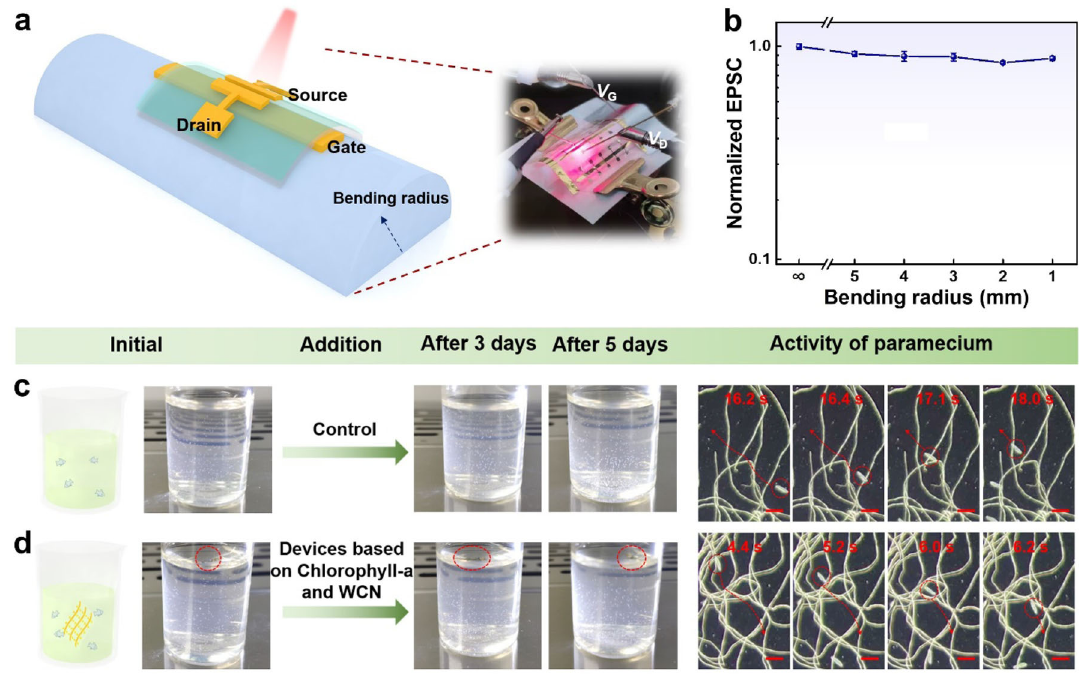
Fig. 6 Flexibility tests and biological toxicity tests of the optoelectronic synaptic transistor. a Schematic and photograph of bending tests on optoelectronic synaptic transistors. b Normalized EPSC (normalized to the initial EPSC tested under the fl at condition) as a function of bending radius. Error bars represent standard errors investigated by three times independent measurements of the synaptic transistor. Biological toxicity tests based on c a pure paramecium culture medium and d a paramecium culture medium with an optoelectronic synaptic transistor array. The red arrows in the 3D optical microscopic images illustrate the trajectory of paramecia. The scale bar in the 3D optical microscopic images is set as 200